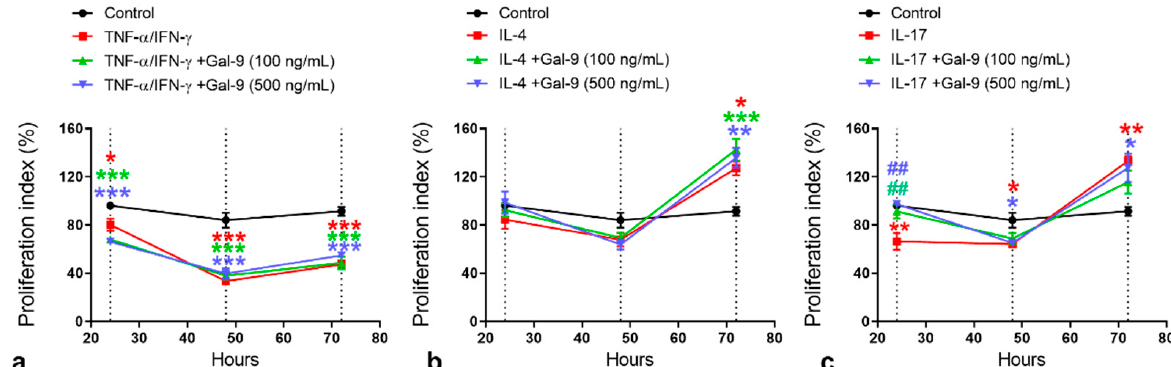
Figure 6. Effect of Gal-9 on HaCaT proliferation rate. Human keratinocytes were submitted to the following experimental conditions: control (growth media) or stimulated with TNF- α /IFN- γ (10 ng/mL; ( a )) IL-4 (100 ng/mL; ( b )) or IL-17 (100 ng/mL; ( c )), and after 15 min they received human recombinant Gal-9 at 100 or 500 ng/mL or media. After 24, 48, and 72 h, an MTT assay was performed to determine proliferation rate (% of control; data represent mean ± SEM) ( n = 3/group in 2 independent experiments). * p < 0.05; ** p < 0.01; *** p < 0.001 vs. control; ## p < 0.01 vs. IL-17-stimulated cells (ANOVA, Bonferroni post-test).